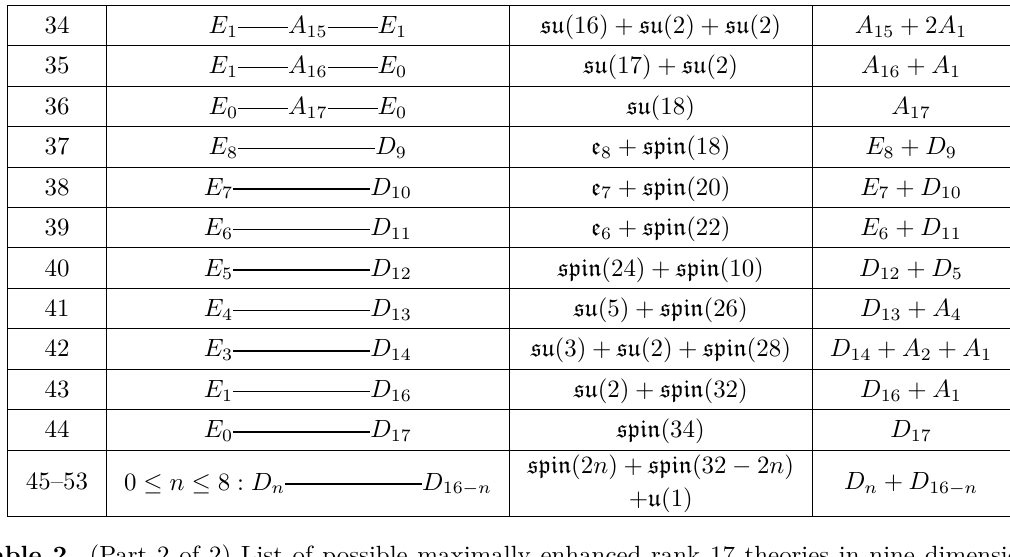
Table 2 . (Part 2 of 2) List of possible maximally enhanced rank 17 theories in nine dimensions which is obtained by Swampland considerations. The first 44 lines where the algebra is semisimple match with table 3 in [49] which have string theory realizations.